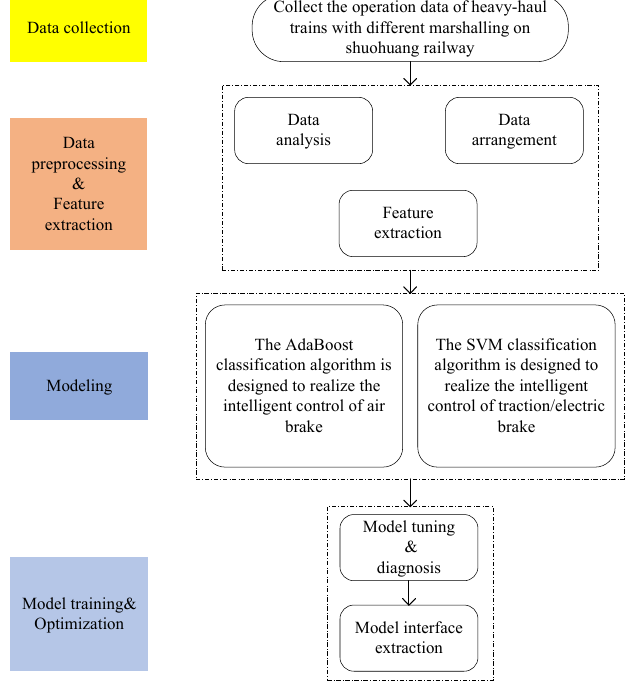
Figure 1. A flowchart for intelligent driving of heavy-haul trains based on machine learning.